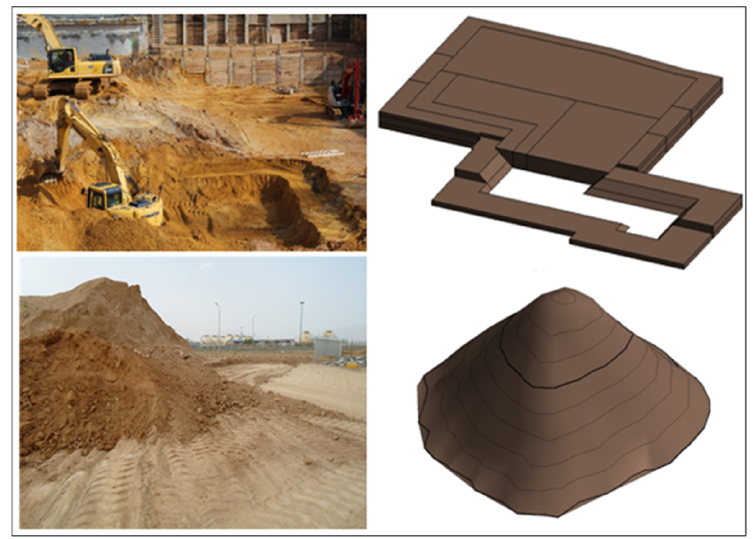
Figure 2. Physical and virtual entities of the construction excavation site and soil deposit/borrow.